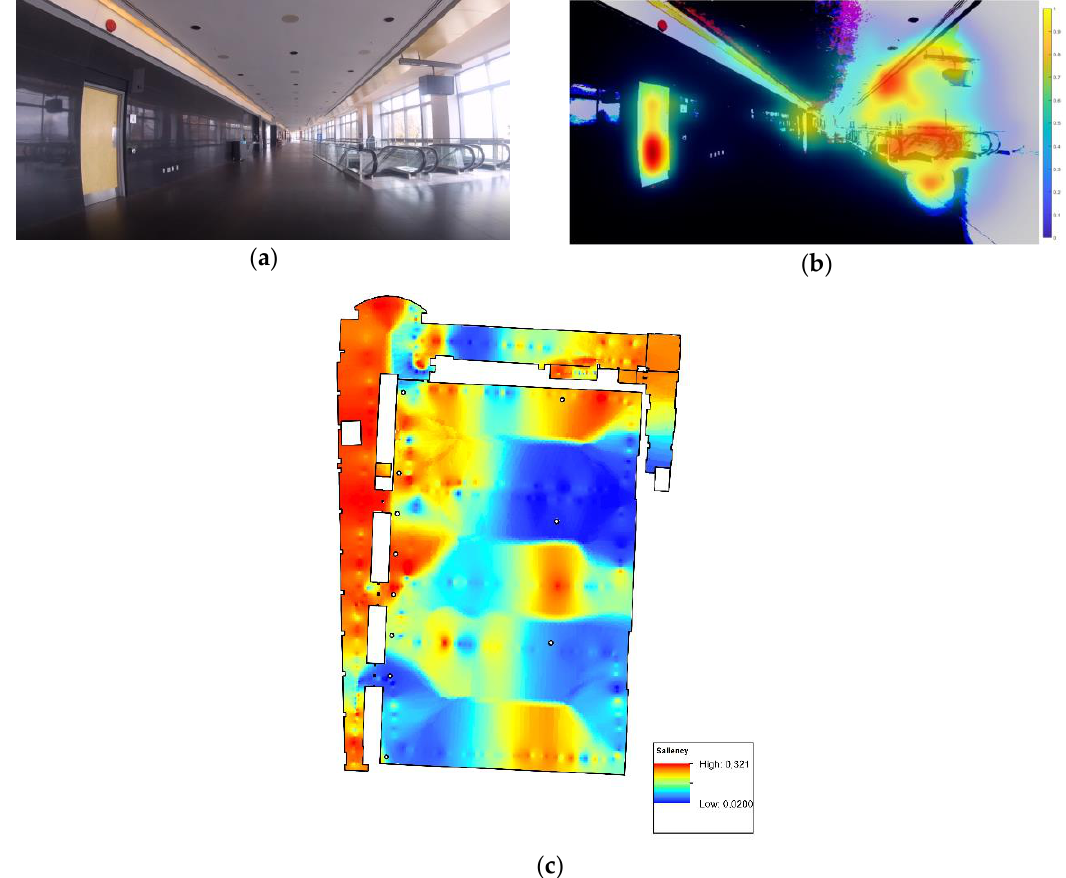
height, ( b ) its saliency map, and ( c ) the saliency of the whole area.